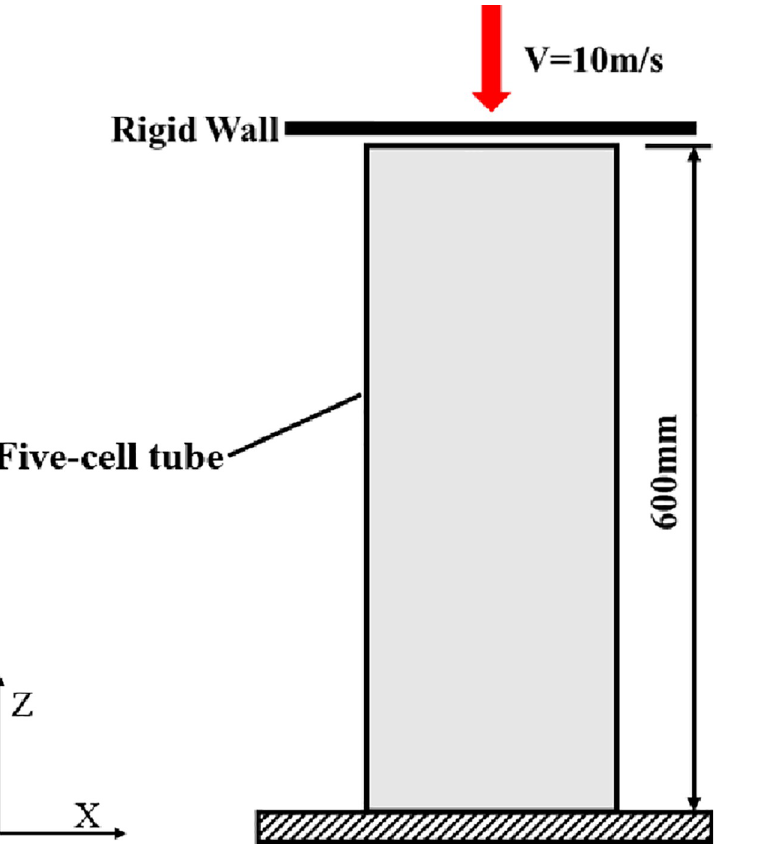
Fig 6. Schematic of the loading arrangement.